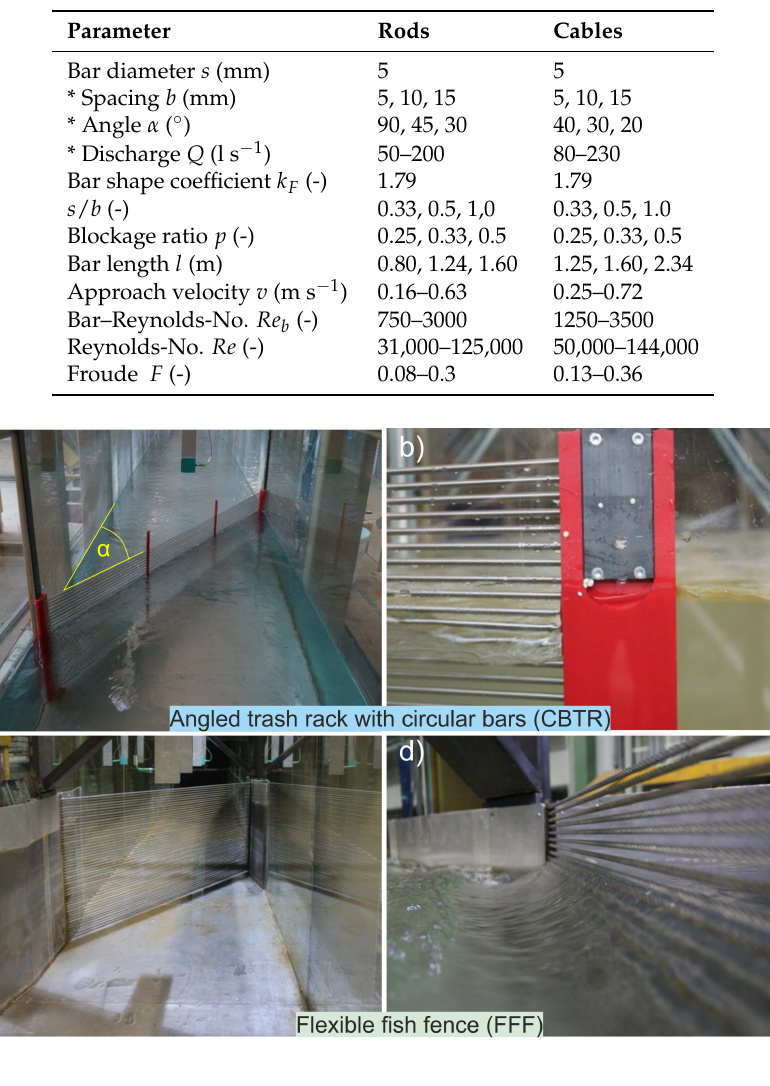
Figure 1. Angled trash rack with circular bars (CBTR) with: α = 30 ◦ and b = 5 m (upstream view) ( a ); detailed side view of bar option from the side of the flume ( b ); Flexible Fish Fence (FFF) with α = 30